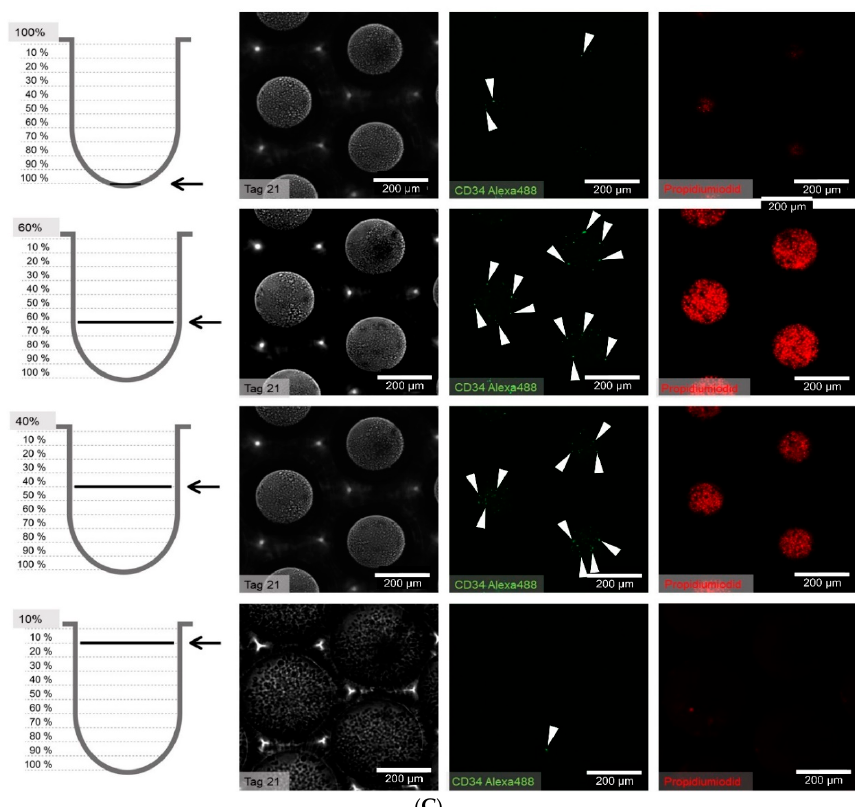
Figure 8. ( A ) Distribution of hHSCs in microcavities after day 1 of co-culture. Scale bar: 200 µm. ( B ) Distribution of hHSCs in microcavities after day 14 of co-culture. ( C ) Distribution of hHSCs in microcavities atfer day 21 of co-culture. White arrowheads point to CD34 + cells. Used antibodies for CD34 + cell detection: CD34 mouse anti-human, ab762, Abcam, and goat-anti-mouse-AlexaFluor488, AC-11001, ThermoFisher Scientific.